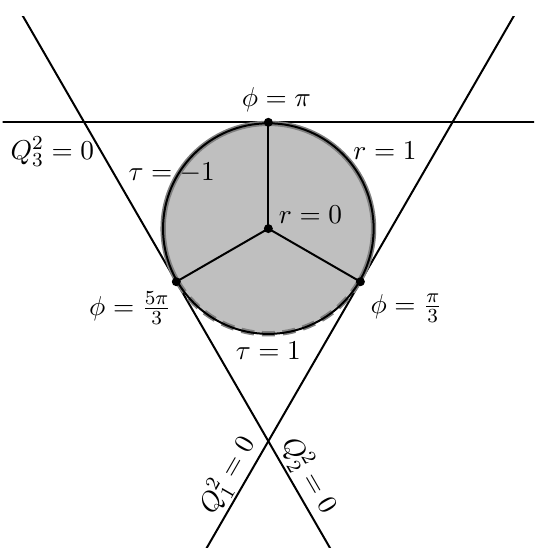
Figure 3. Integration region for ( g corresponds to (cid:28) = line). The angles (cid:30) = (cid:25)= 3, (cid:30) = (cid:25) , and (cid:30) = 5 (cid:25)= 3 correspond to Q 2 respectively. The three points where one of the Q 2 The height of the equilateral triangle is given by